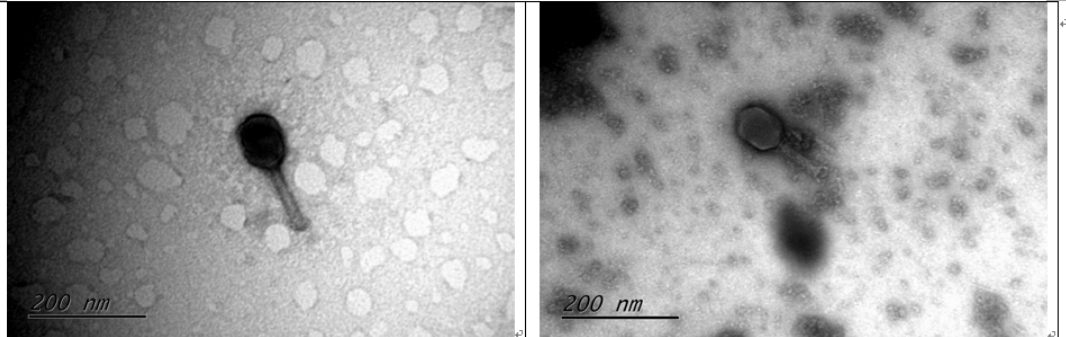
Figure 1. Morphological observations of MHS112 ( left ) and GMS130 ( right ) bacteriophages from transmission electron microscopy.